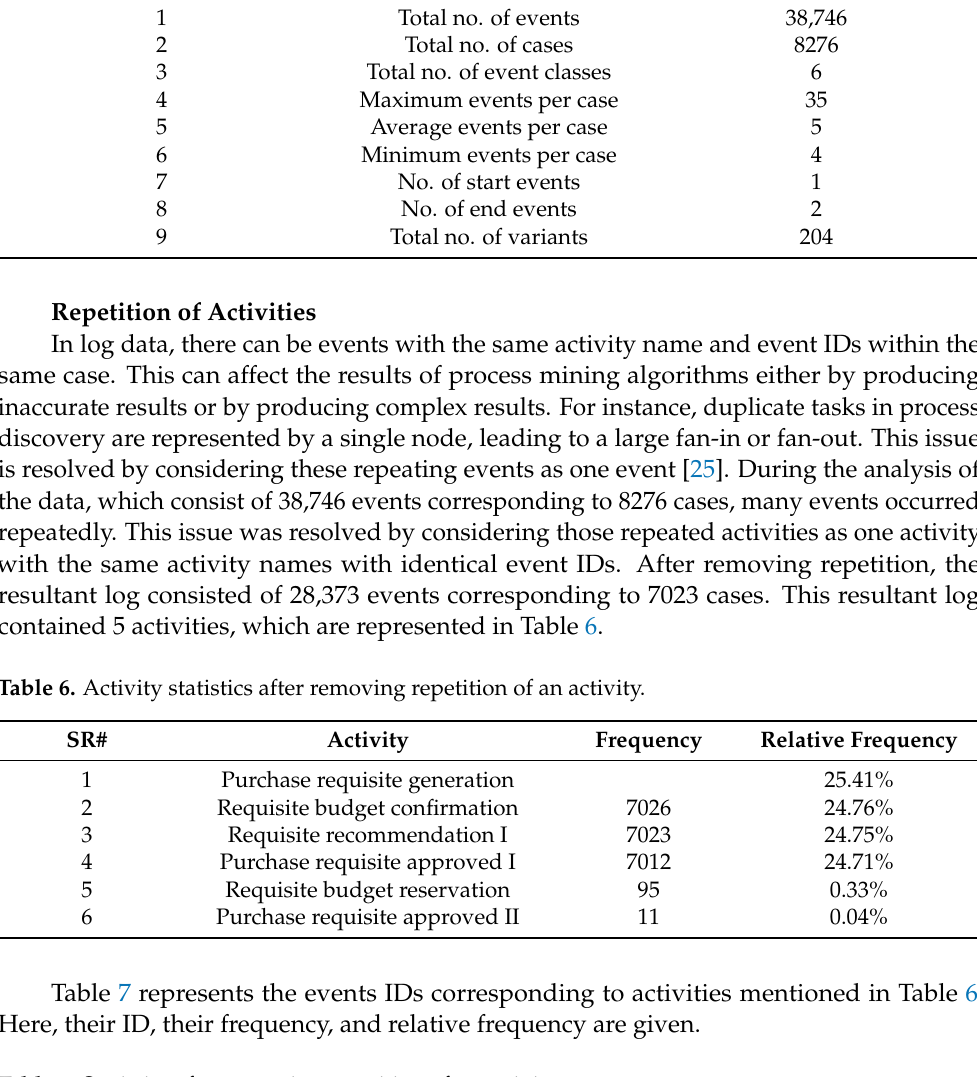
Table 7. Statistics after removing repetition of an